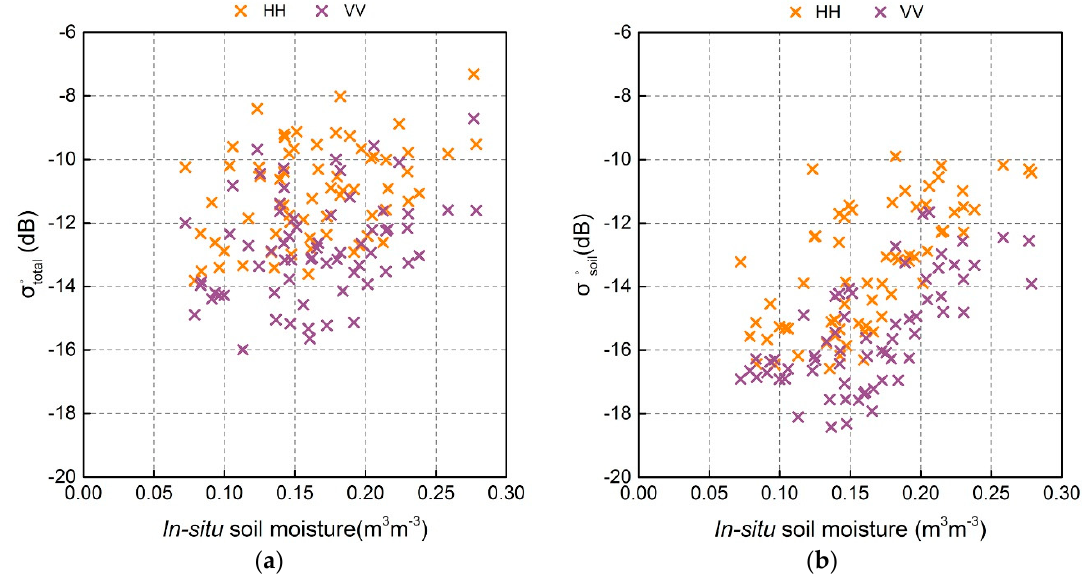
Figure 8. Correlations between in-situ soil moisture and ( a ) total backscatter, ( b ) bare soil backscatter. Table 4. Correlation of (cid:2026) (cid:3047)(cid:3042)(cid:3047)(cid:3028)(cid:3039)° and (cid:2026) (cid:3046)(cid:3042)(cid:3036)(cid:3039)° backscatter with in-situ soil moisture.